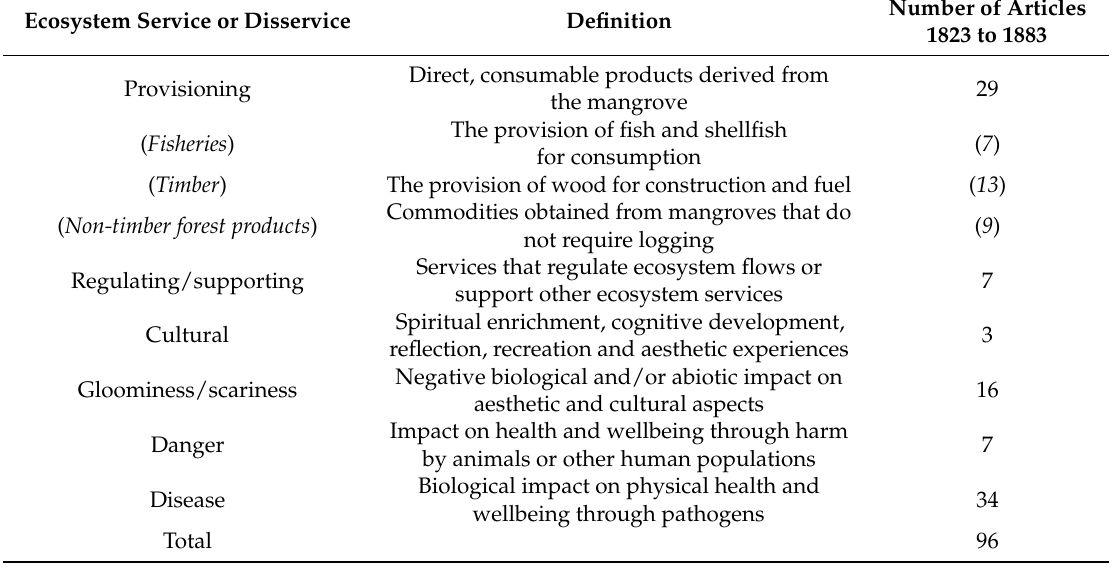
Table 1. Results of a literature review for historical mangrove ecosystem services and disservices between 1823 and